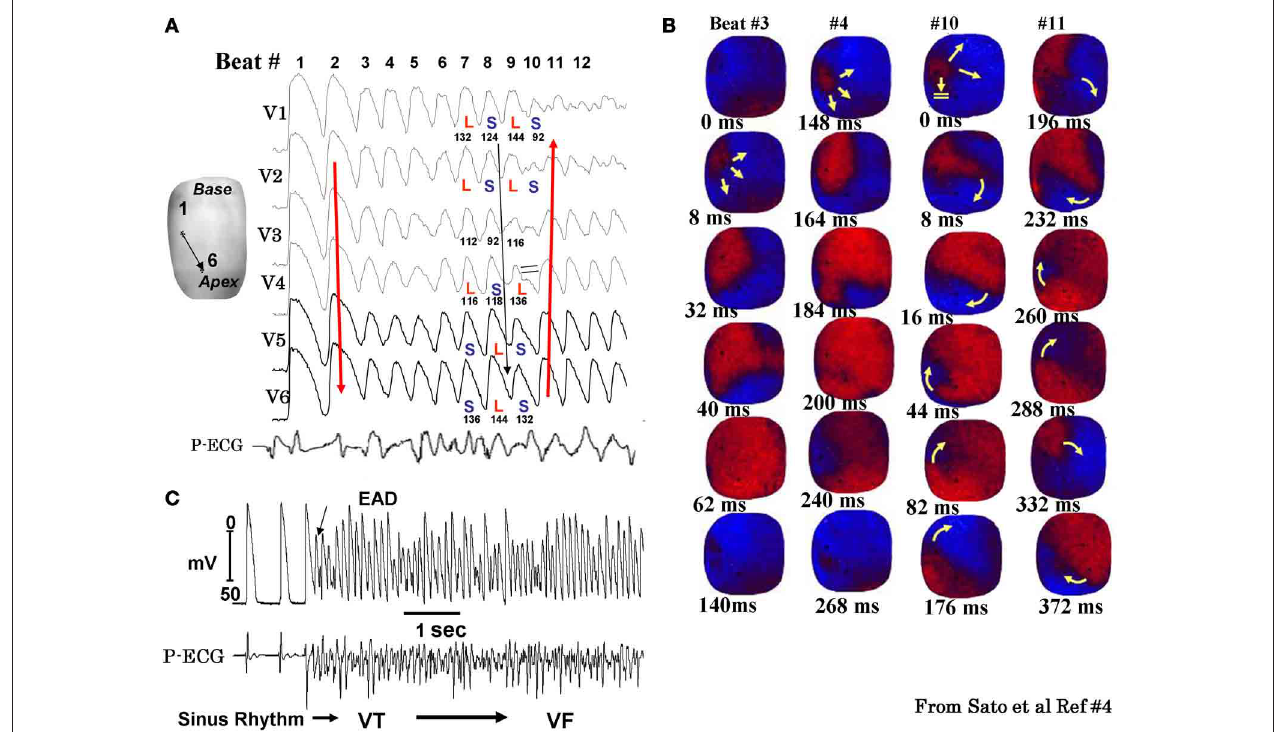
shown in the snap shots of beat #11 in panel (B) . The red color in the snap shots represents depolarization and the blue repolarization. The yellow arrows in the snap shots represent the direction of the wavefront propagation with double horizontal lines denoting the site of conduction block. The numbers under each snap shot is activation time starting with arbitrary zero ms for beast #3 and #4 and then again for beats #10 and #11. Panel (C) is a microelectrode recording of another VF episode recorded in the same heart showing spontaneous initiation of VF by a mechanism compatible with EAD-mediated TA (from Sato et al.,